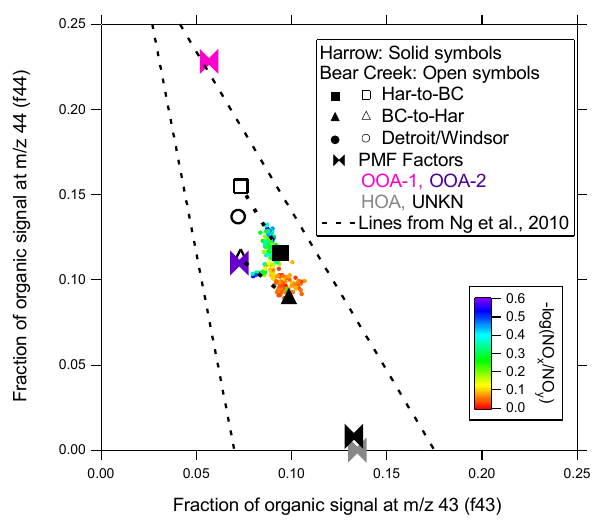
Fig. 9. Fraction of organic signal at m/z 43 and 44 ( f 43, f 44) at each site during the three case study periods. All measurements are shown for the highly photochemical age-dependent measure- ments of the Detroit/Windsor plume at Harrow (see Fig. 7); oth- erwise, average values are shown. Dashed lines colored for the inter-site transport periods (Harrow-to-Bear Creek and Bear Creek- to-Harrow) connect measurements at the two sites to guide the eye. Values are also shown for the 4 PMF factors. Dashed black lines de- note the approximate range of f 44 and f 43 from ambient OOA-1 and OOA-2 factors (Ng et al.,